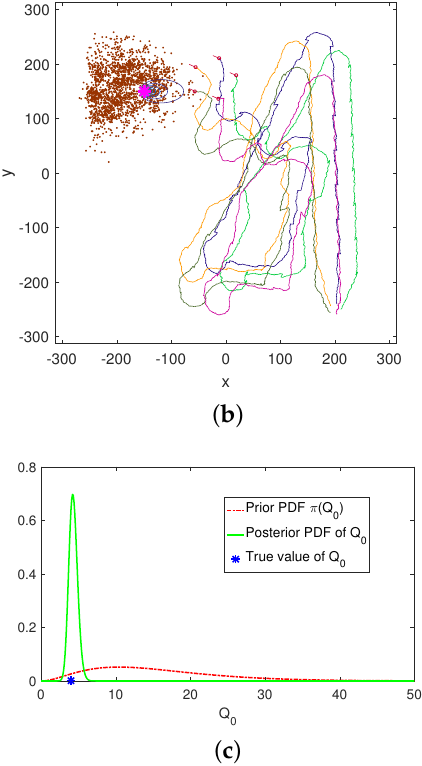
Figure 2. An illustrative run of the multi-robot search algorithm. Figures ( a ) and ( b ) show the search area, the paths of N = 5 platforms, and the Monte Carlo samples (brown coloured dots) { r at k = 2 and k = 33, respectively. The true source location is indicated by a pink asterisk. The contours of the mean plume are plotted with blue lines. Figure ( c ) shows the prior probability density function (PDF) π ( Q 0 ) (red dashed line), the posterior PDF p ( Q 0 | r 0 , z 1: k ) at k = 48 (green solid line), and the true value of Q 0 = 4 (blue asterisk).